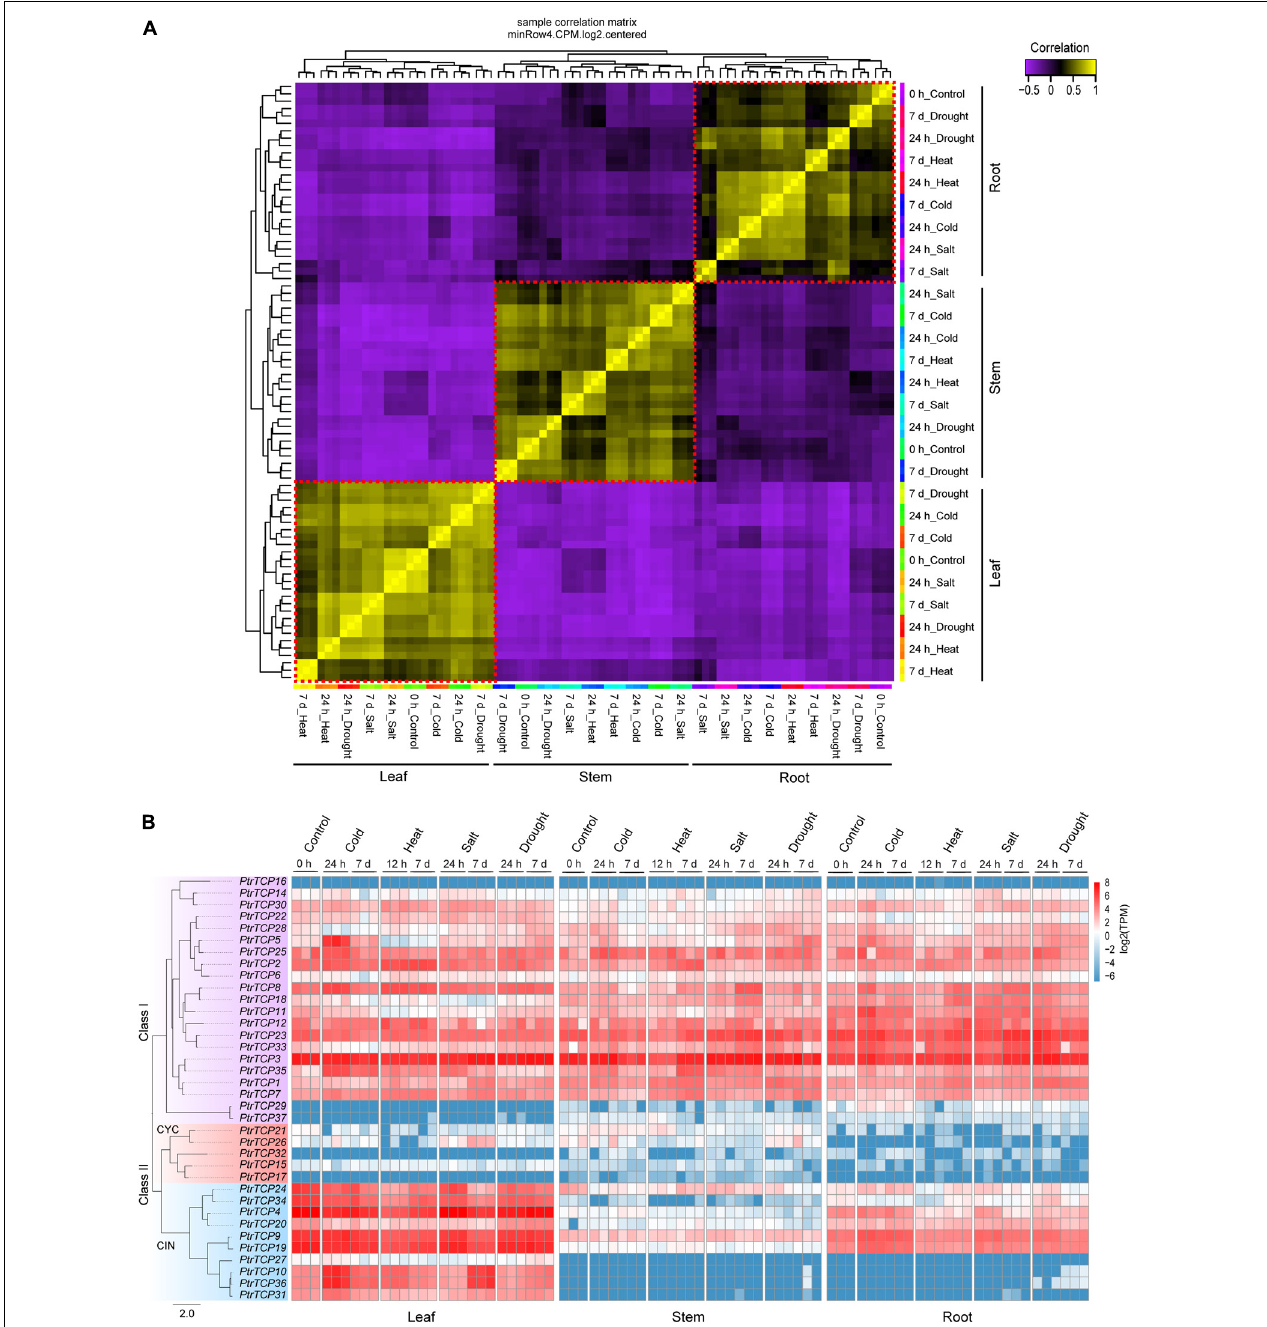
FIGURE 4 | Transcriptional expression patterns of PtrTCP genes in different tissues under cold, heat, salt, and drought stresses. (A) Correlation heat map of the samples based on transcriptome-scale expressed genes. Three clear clusters in red dotted boxes were obtained in consistence with root, stem, and leaf samples. (B) Expression heat map of PtrTCP genes. The values of transcripts per million reads (TPM) were used to represent the expression levels of PtrTCP genes.